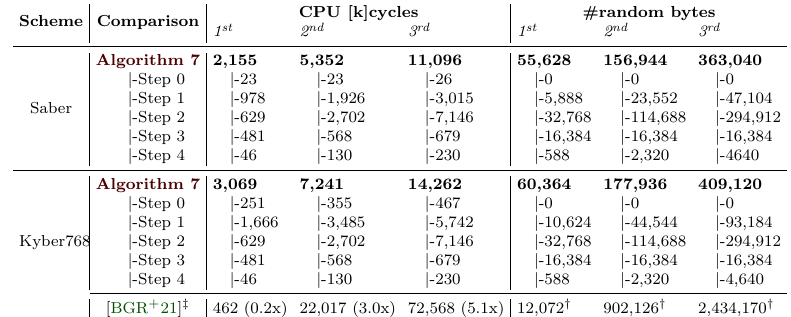
Table 3: Performance breakdown of our masked comparison on ARM Cortex-M4 with collision probability 2 − s = 2 − 118 Scheme Comparison